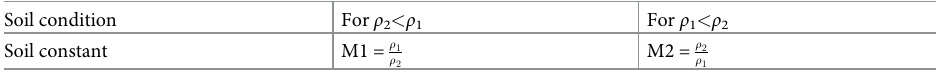
Table 4. Soil constant for horizontal two-layer soil model